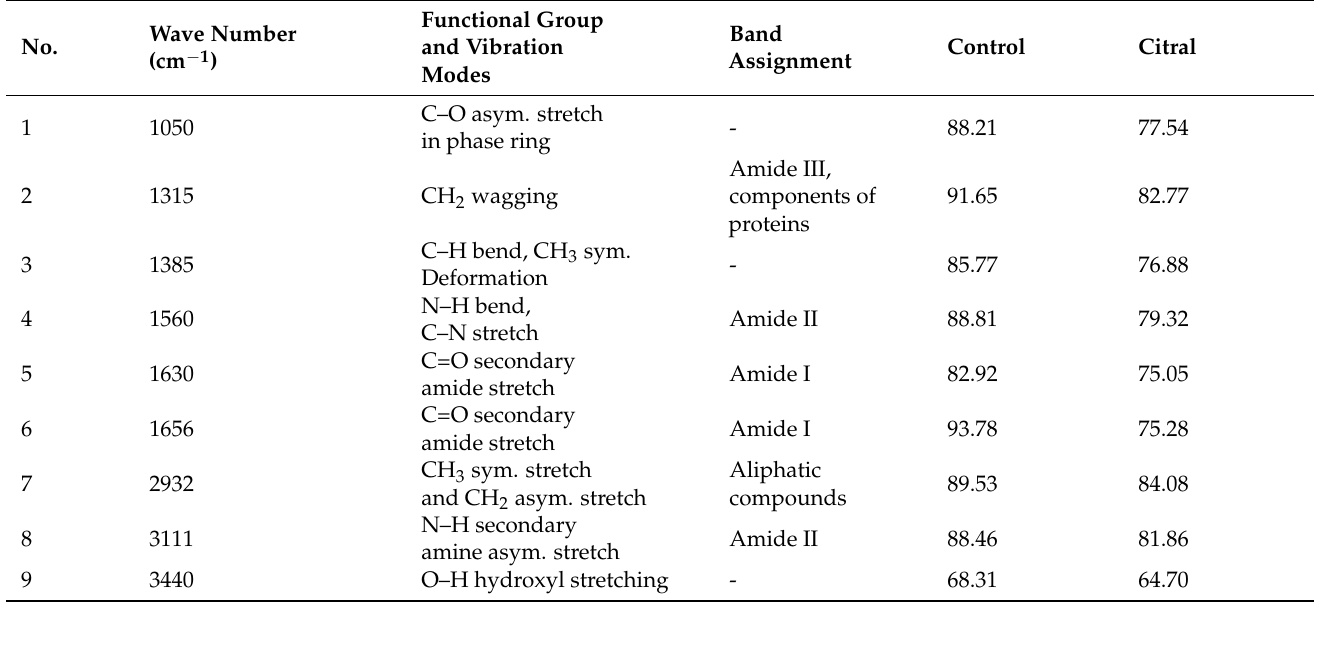
Table 3. Characteristics and variations in bands in the FTIR spectra of the chitin of R. flaviceps treated